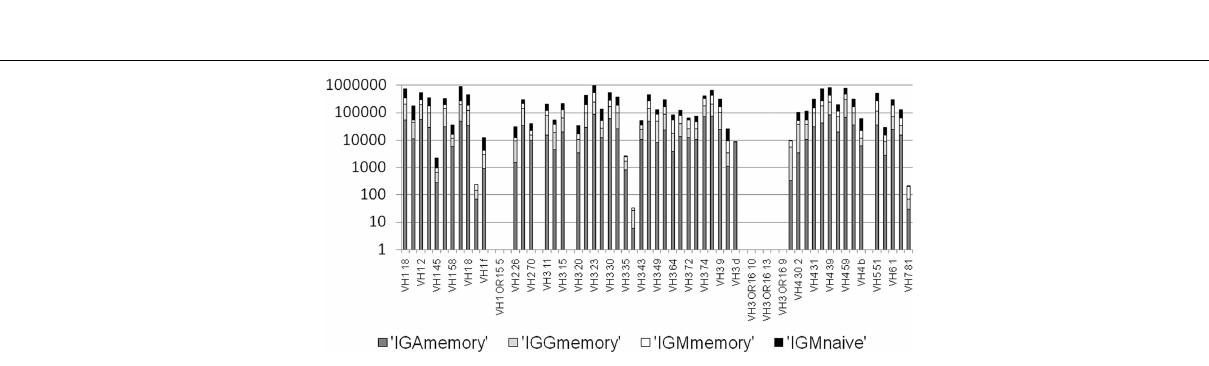
FIGUREA3 | Number of mutation events perVH gene per isotype .There are practically no mutations assigned to pseudogenes, since practically none of the sequenced in-frame lineage trees are based on pseudogenes (<0.05%). However, there are also some functionalVH genes with practically no lineage trees.We removed those from the current